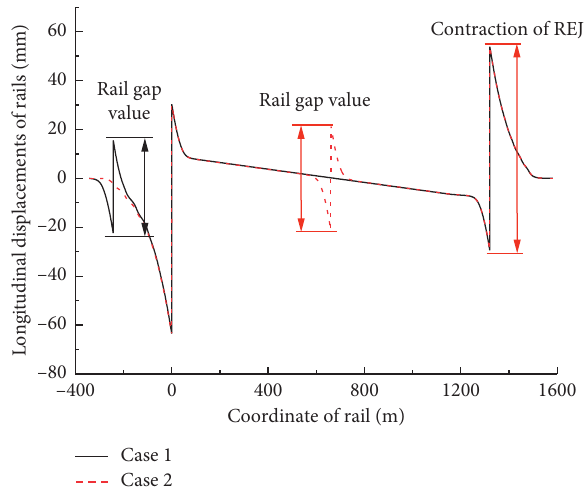
Figure 12: Rail longitudinal